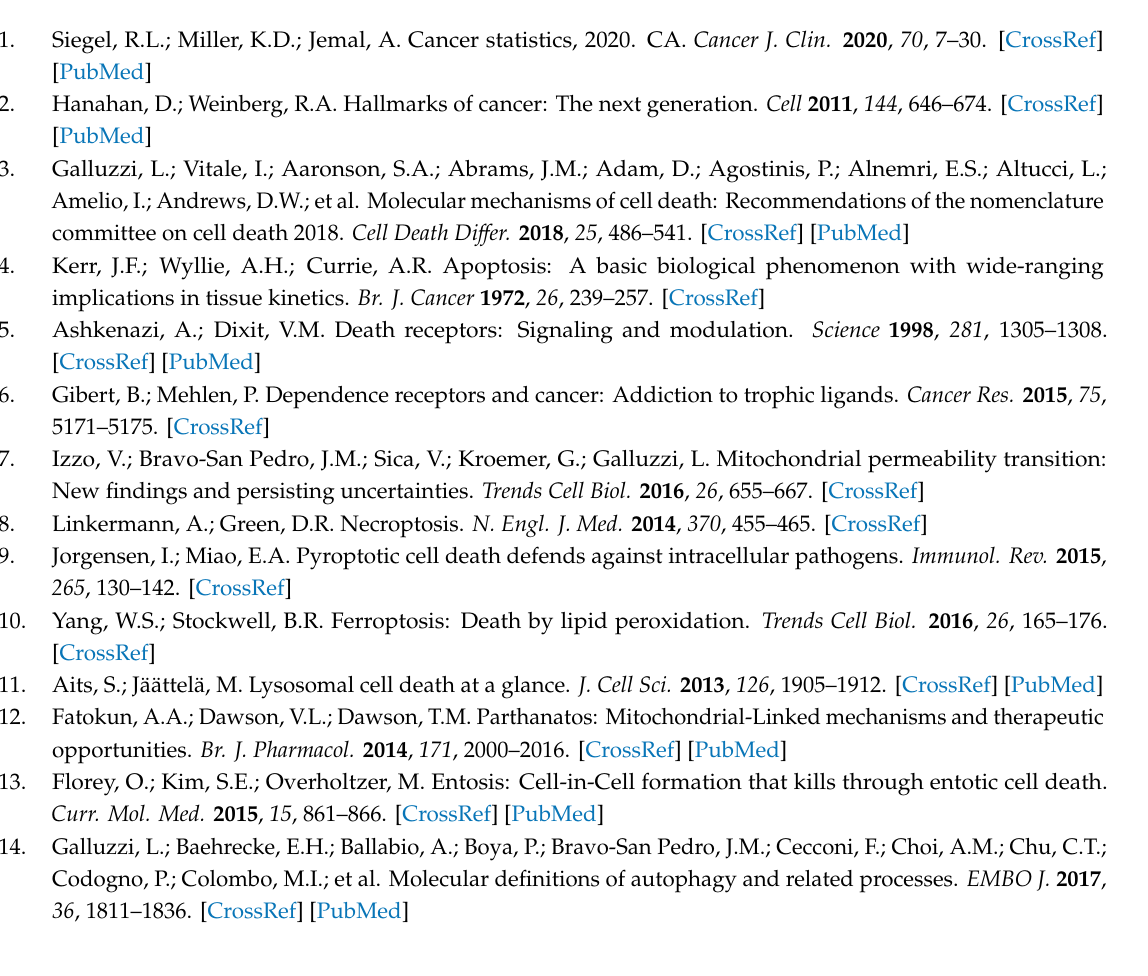
Figure S1, Dendrogram of WGCNA modules of cell-death-related treatments; Figure S2, Dendrogram of WGCNA modules of controls; Figure S3, medianRank and Zsummary statistics of modules in module preservation; Table S1, List of RNA-seq datasets; Table S2, H. sapiens DEGs with same expression pattern related to apoptosis or autophagy and conserved in S. cerevisiae; Table S3, Gene ontology enrichment of WGCNA modules; Table S4, Pathways enrichment; Table S5, List of H. sapiens cell-death DEGs and S. cerevisiae orthologs and their expression during cell death; Table S6, HumanNet current knowledge or disease prediction for the 32 H. sapiens – S. cerevisiae ortholog genes; Table S7, Parameters used for